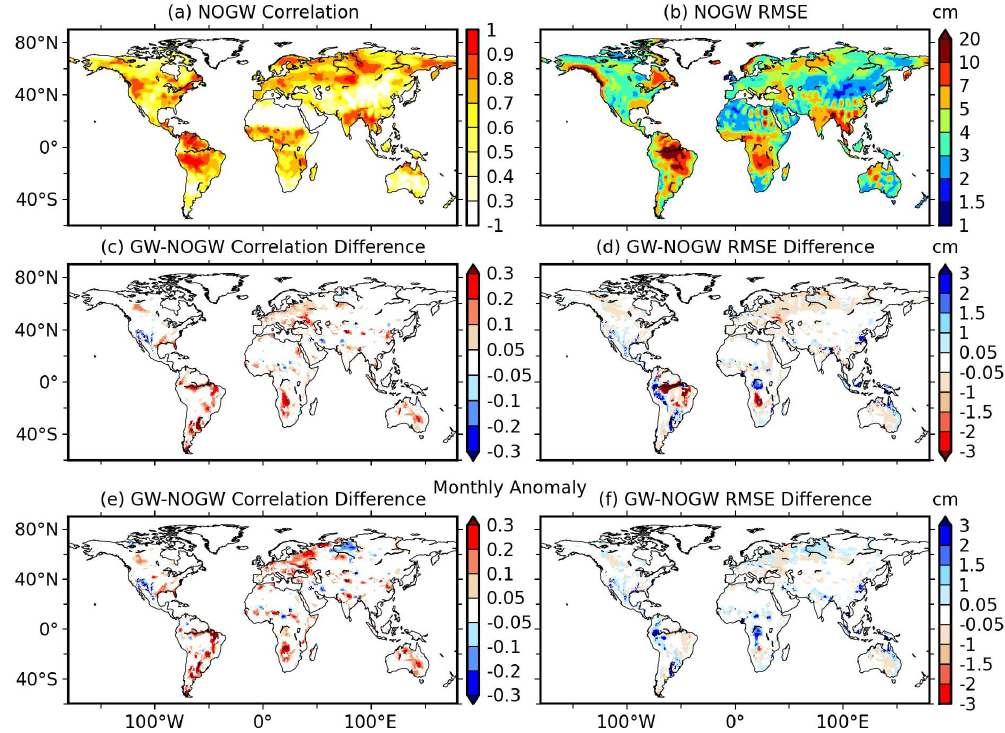
Fig. 7. Comparison of the simulated TWS with (GW) and without (NOGW) groundwater: (a) monthly correlation and (b) RMSE of the simulated NOGW 1 TWS over the whole GRACE period, and (c) differences between GW and NOGW in terms of correlation and (d) RMSE. (e) The monthly anomaly differences are also shown in terms of correlation and (f)